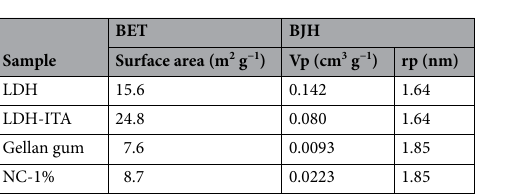
Table 1. Textural properties of the synthesized